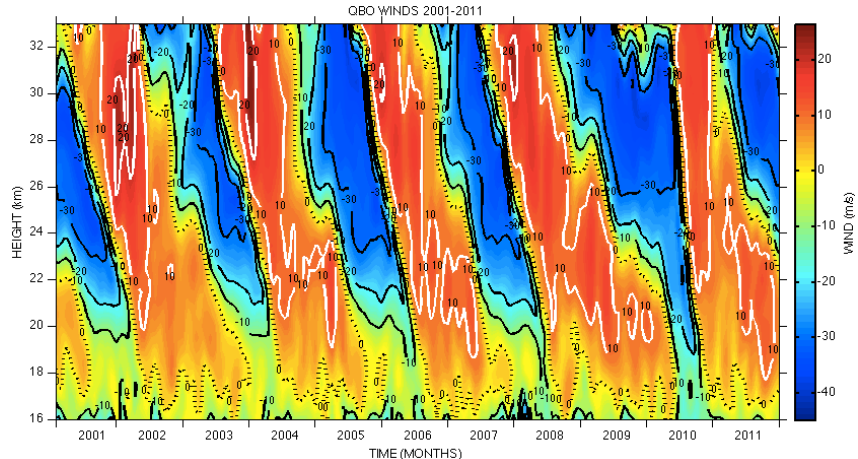
Fig. 6. The Singapore radiosonde QBO wind data from 2001 to 2011, with the contours steps of 10 m s − 1 (http://www.cdc.noaa.gov/data/correlation/qbo.data).